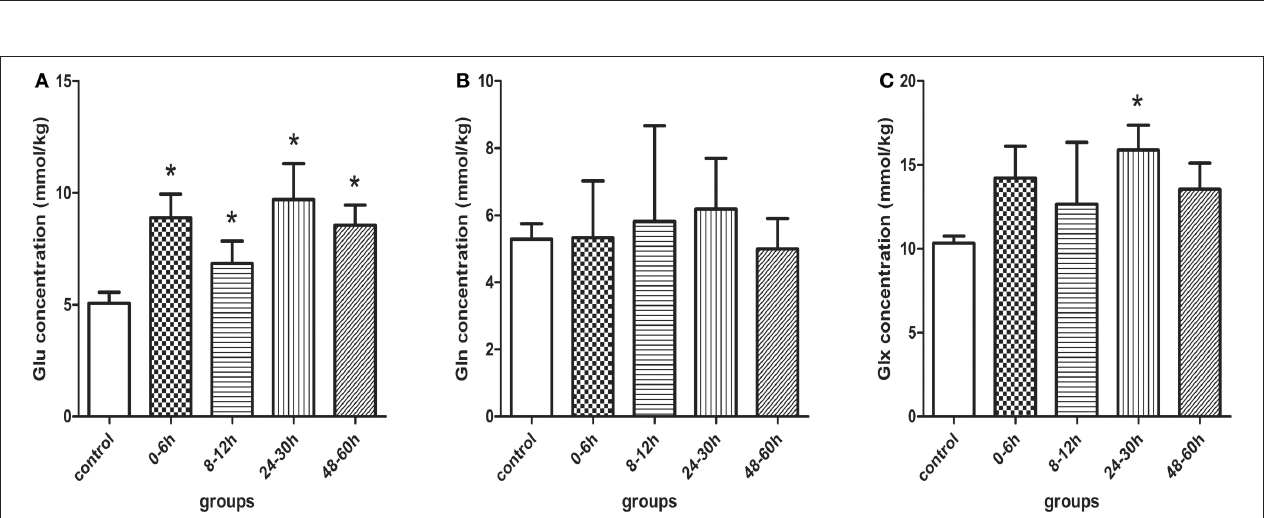
FIGURE 4 | Quantification results measured by 1 H-MRS in control and model piglets at different time-points after HI insult , (A) Glu, (B) Gln, and (C) Glx. Errors bars indicate standard deviation values. *Compared with the control group, P < 0.05. Glu, glutamate; Gln, glutamine; Glx, glutamate + glutamine.